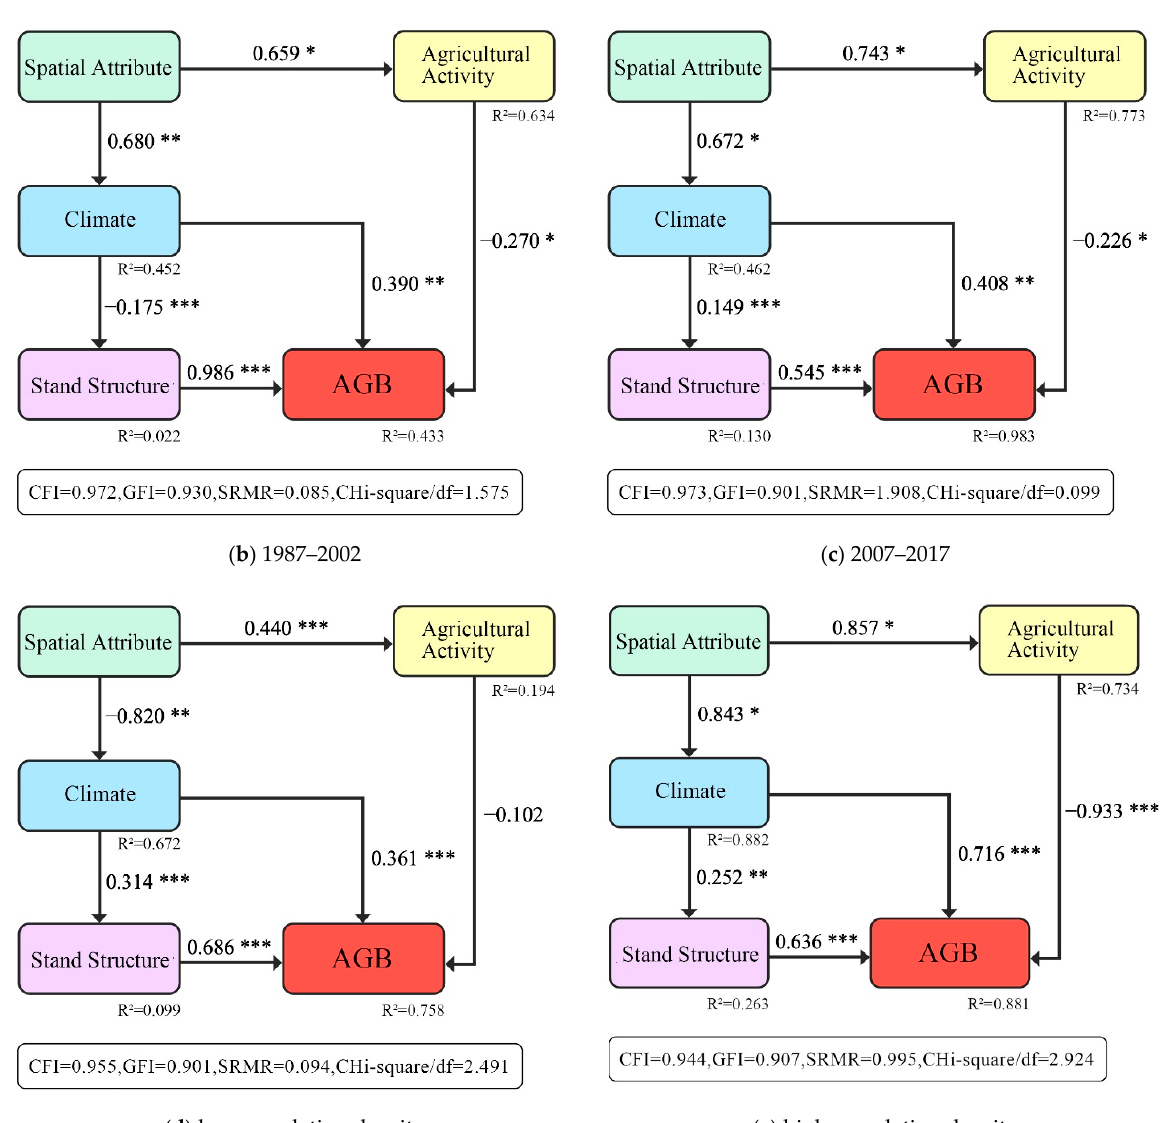
Figure 5. The SEM results can reveal four drivers’ direct and indirect effects on AGB changes of Pinus densata . Arrows indicate pathways, numbers next to arrows are normalized path coefficients, and * indicates significance levels (significance levels are as follows: ***, p < 0.001; **, p < 0.01; *, p < 0.1). R 2 represents the coefficient of determination of the endogenous latent variable. ( a – e ) describe the results of SEM models at different scales, respectively.